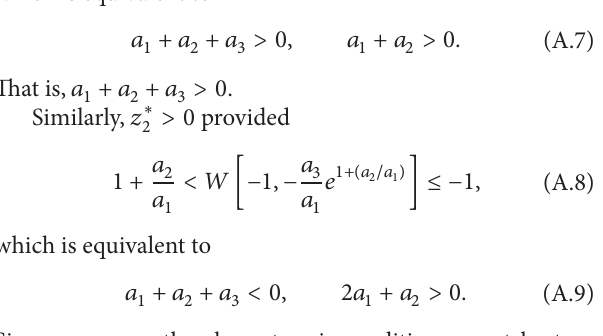
which is equivalent